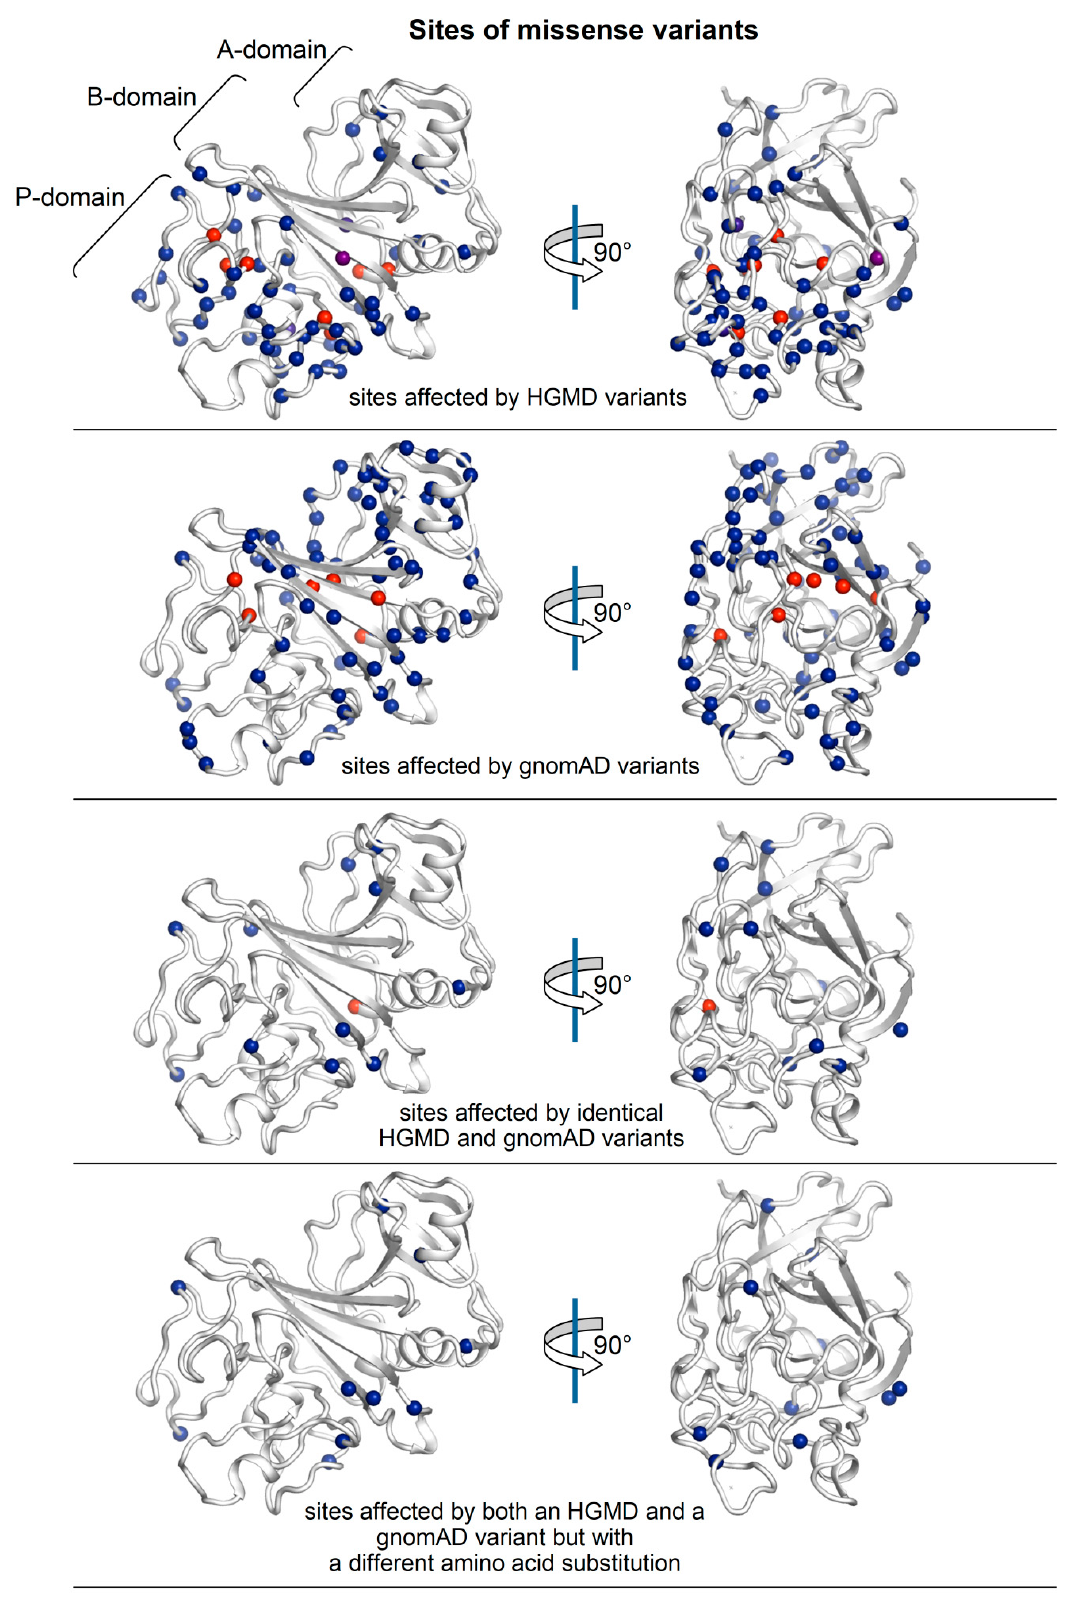
Figure 2. Sites of HGMD and gnomAD missense variants falling in the γ -module of fibrinogen (C α atoms of affected residues are shown as a sphere in a blue-red gradient according to their distance from the surface of the module: blue, surface-exposed residues; red, residues more in the core of the module).